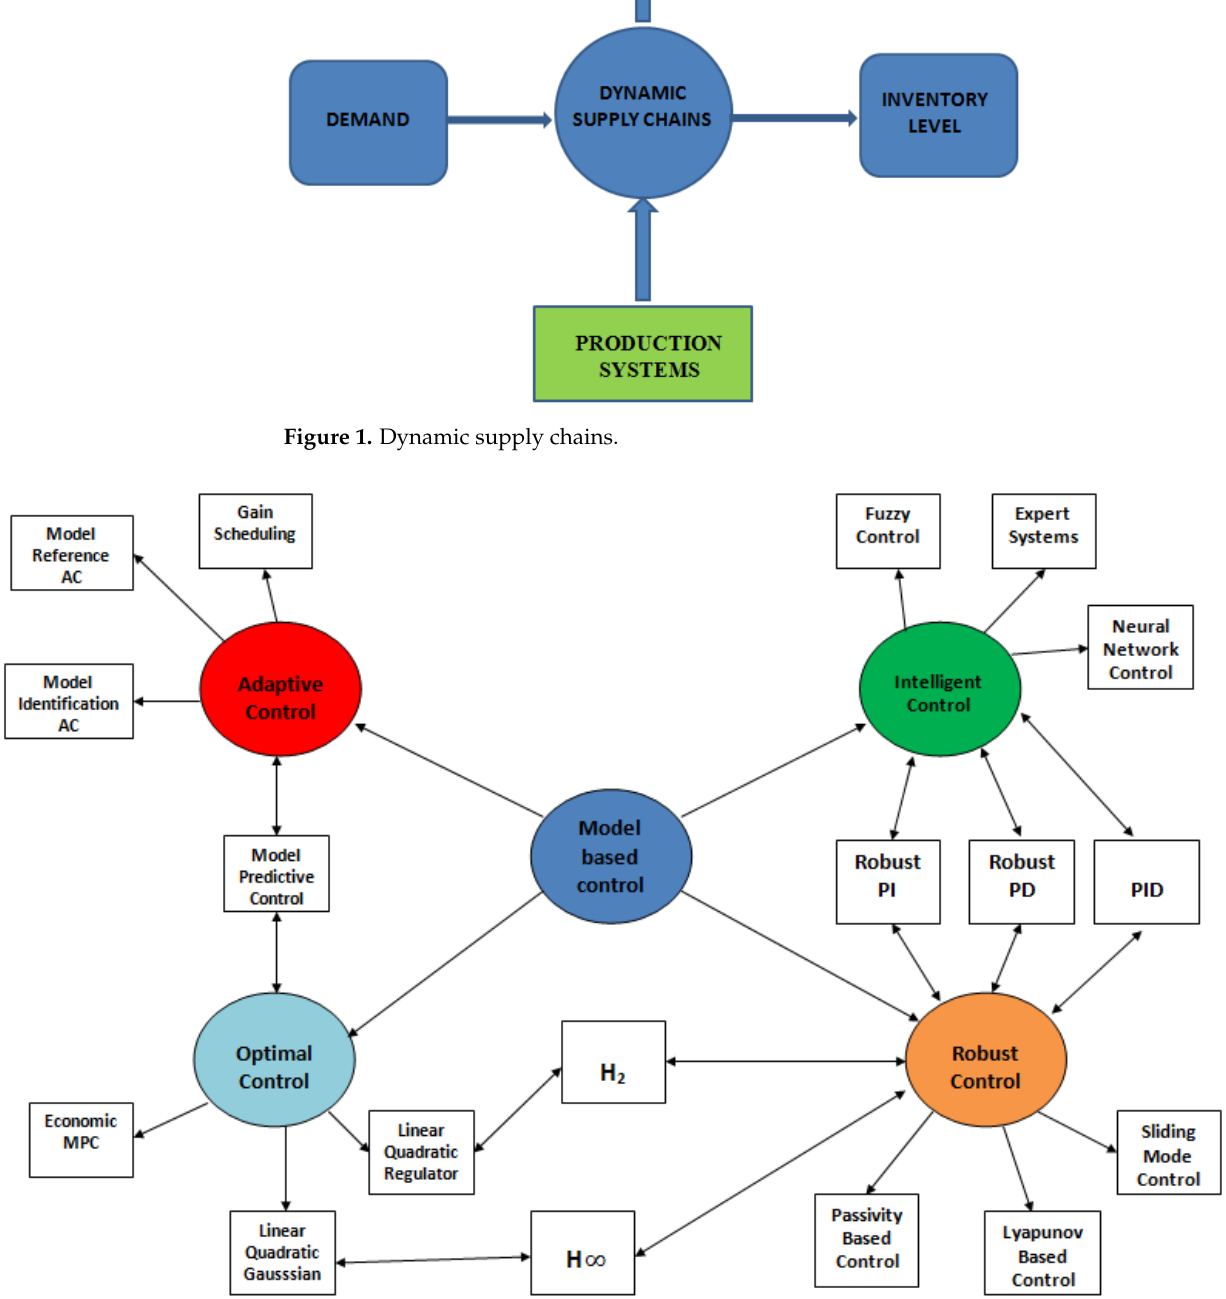
Figure 2. Model-based control systems (adapted from [18]).